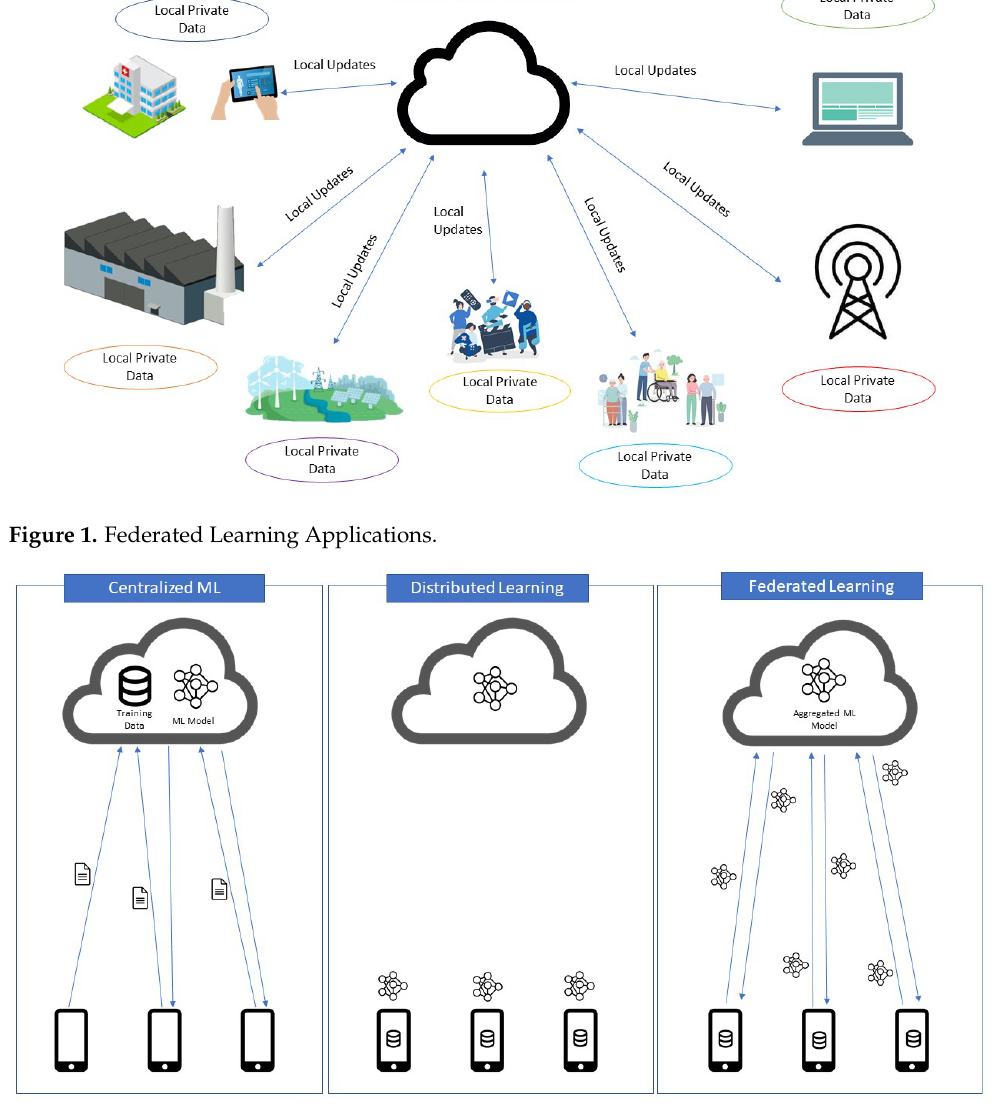
Figure 2. DifferenceBetweenCentralizedMachineLearning,DistributedLearningandFederated